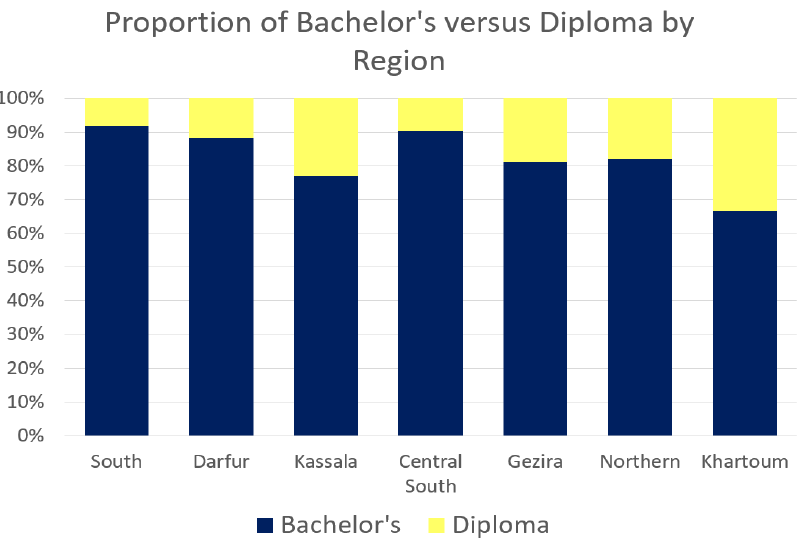
Figure 11. Percentages of bachelor’s and diploma students by region